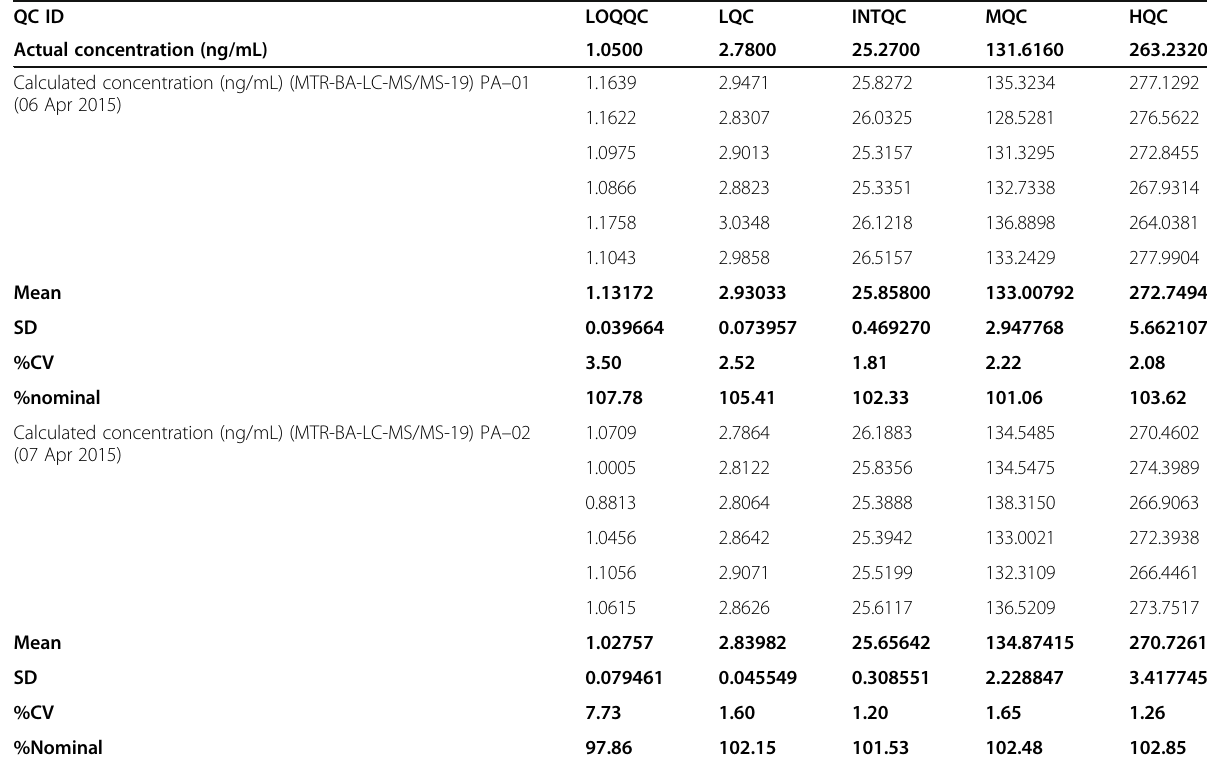
Table 8 Intra-batch precision and accuracy of bexarotene